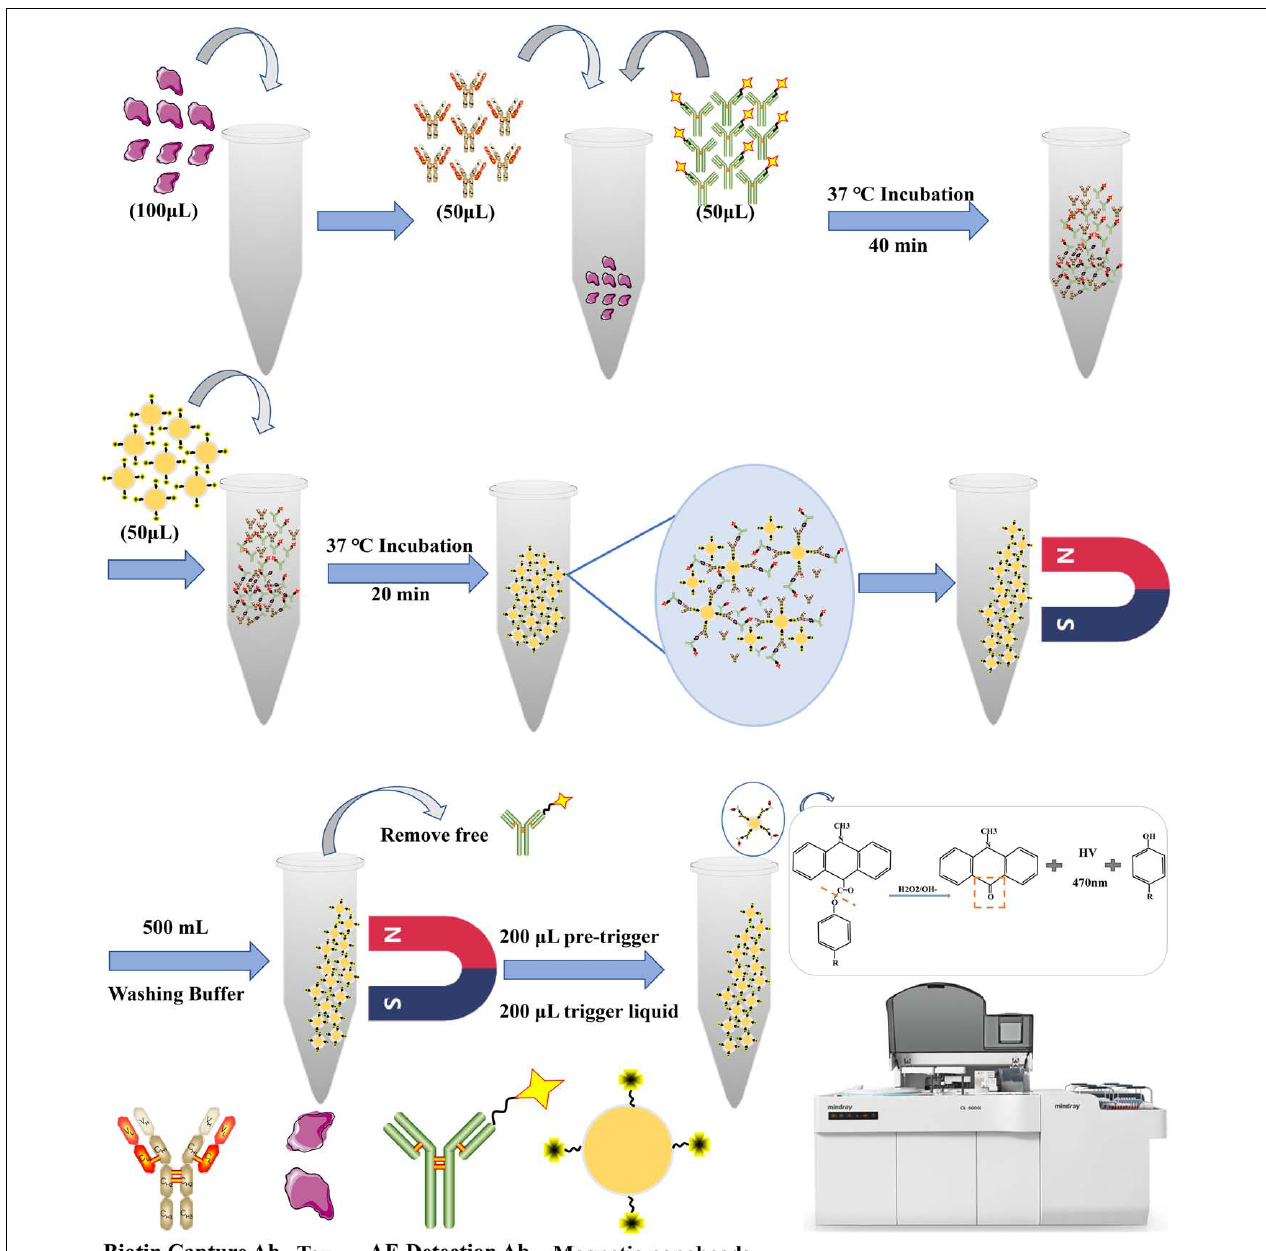
FIGURE 1 | Schematic diagram of CLIA-based technology for total Tau quantification in plasma.